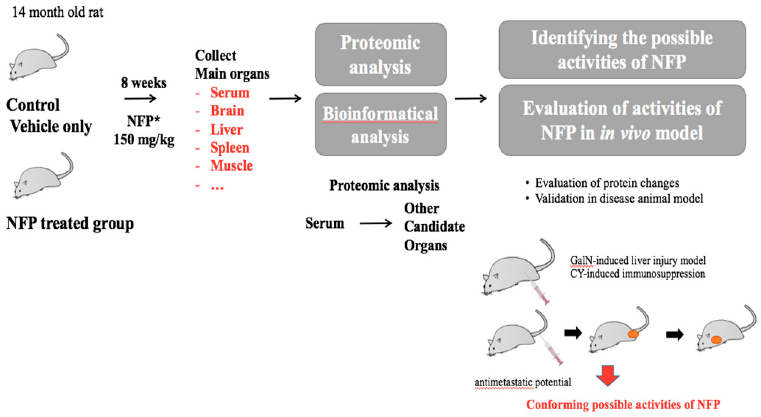
Figure 6. Schematic diagram of the experiments for the biological effects of NFP.